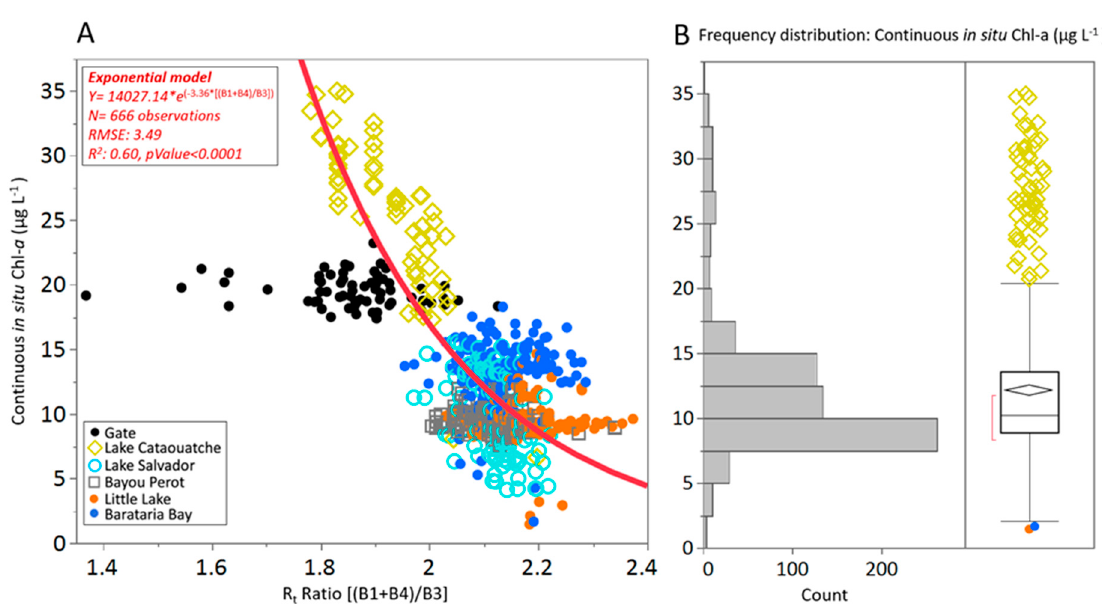
Figure 7. ( A ) Exponential model between the continuous in situ Chl- a and the R t ratio (B1 + B4)/B3. ( B ) Continuous in situ Chl- a distribution frequency. The bold red solid line shows the exponential model fit. The model was constructed based on a total of 666 observations sampled on 22 February 2020 in the BB complex. Gate observations were not considered in the model calculation (see methods and discussion sections).